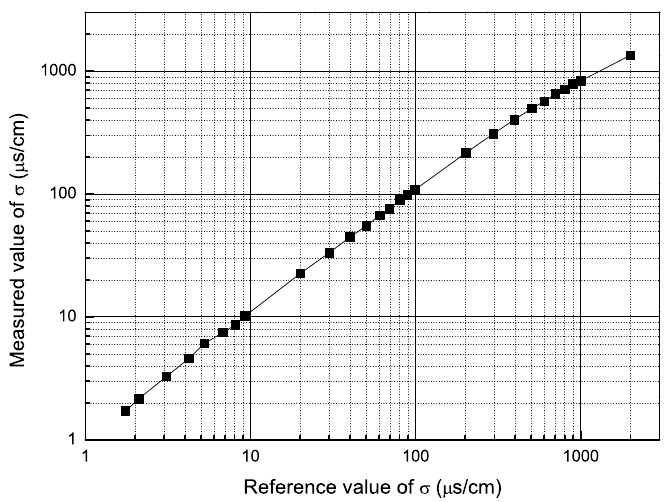
Figure 9. Measured value of the medium conductivity vs . the reference value.